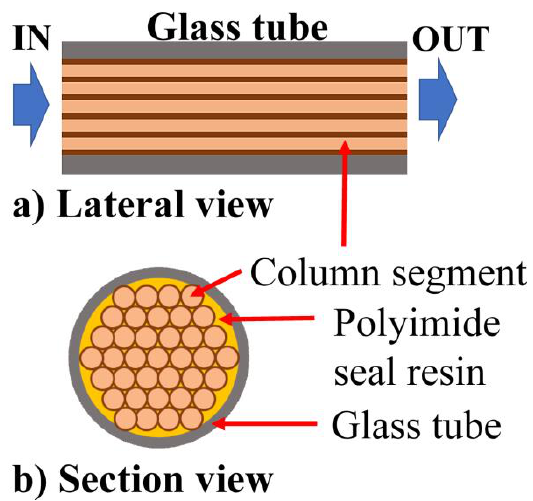
Figure 3. Schematic representation of lateral and frontal sectional views of the PCC.